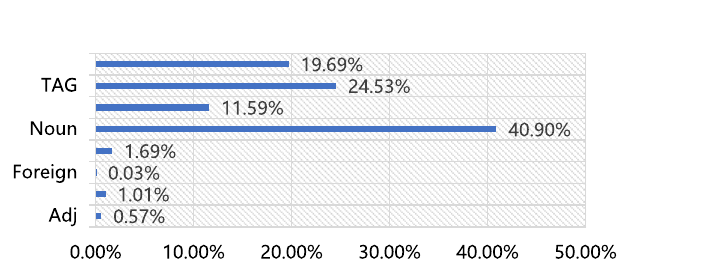
Figure 6. Word frequency by part of